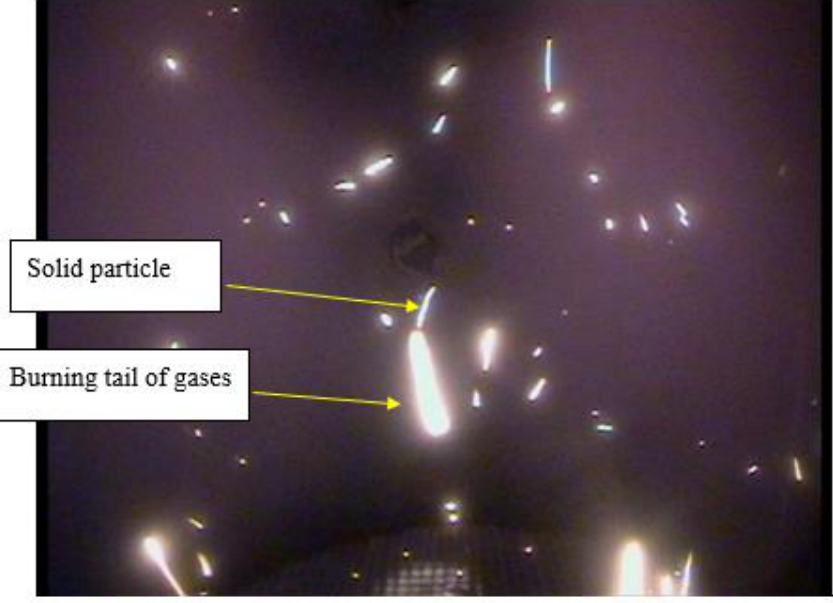
Figure 2. Experimental photo image by high speed camera showing the influence of moisture and volatile releases on the biomass particle motion.